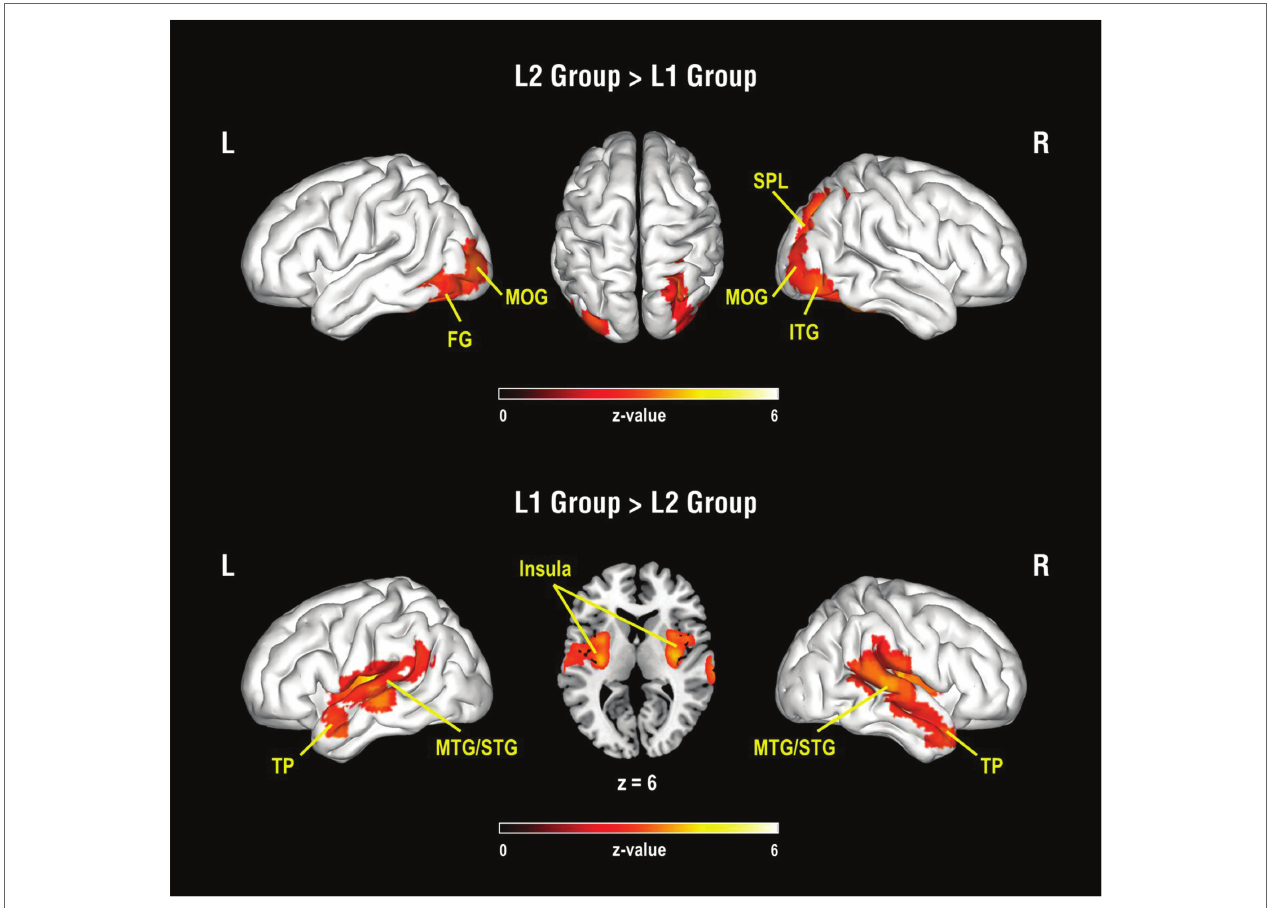
FIGURE 1 | Results of group comparisons for the contrast of semantic-related condition vs. perceptual control condition. The upper panel is the activated brain areas for the comparison of the L2 group vs. L1 group, and the lower panel is the activated brain areas for the comparison of the L1 group vs. L2 group. L, Left hemisphere; R, Right hemisphere; FG, fusiform gyrus; MOG, middle occipital gyrus; SPL, superior parietal lobule; ITG, inferior temporal gyrus; TP, temporal pole; MTG, middle temporal gyrus; STG, superior temporal